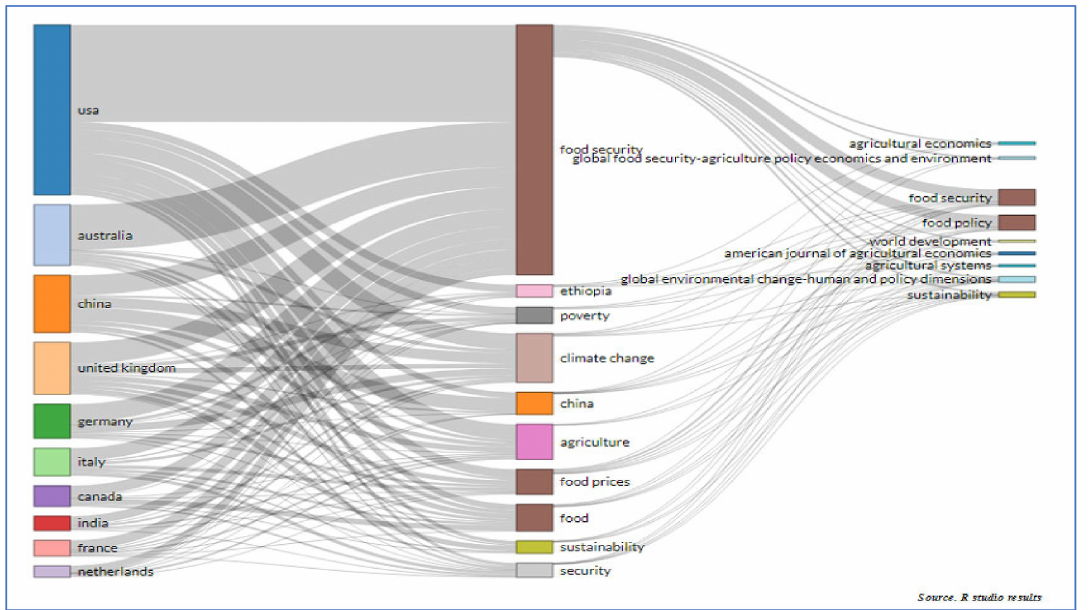
Figure 11. Three fields plot: relations between countries (left), author keywords (middle), and sources (right). Source R studio